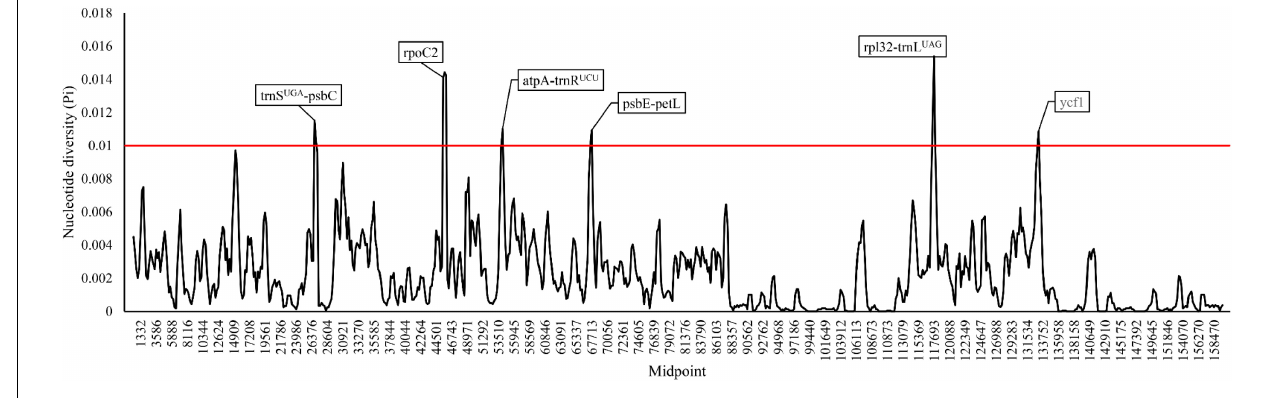
FIGURE 3 | Sliding window analysis of the whole plastomes of the 52 Arachis accessions.